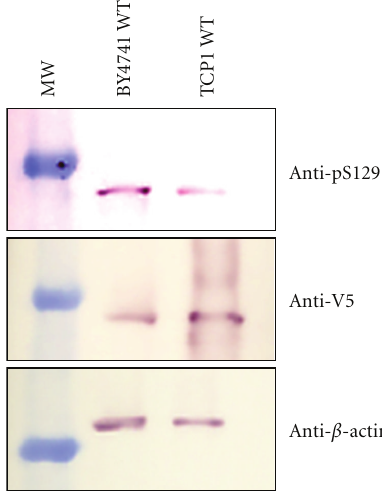
Figure 1: WT α -synuclein is phosphorylated at serine-129 in both yeasts. Western blot of BY4741 WT and TCP1WT lysates probed with anti-pS129 (top), anti-V5 ( α -synuclein; middle), and protein loading control anti- β -actin (bottom). WT α -synuclein is phosphorylated at serine-129 in both